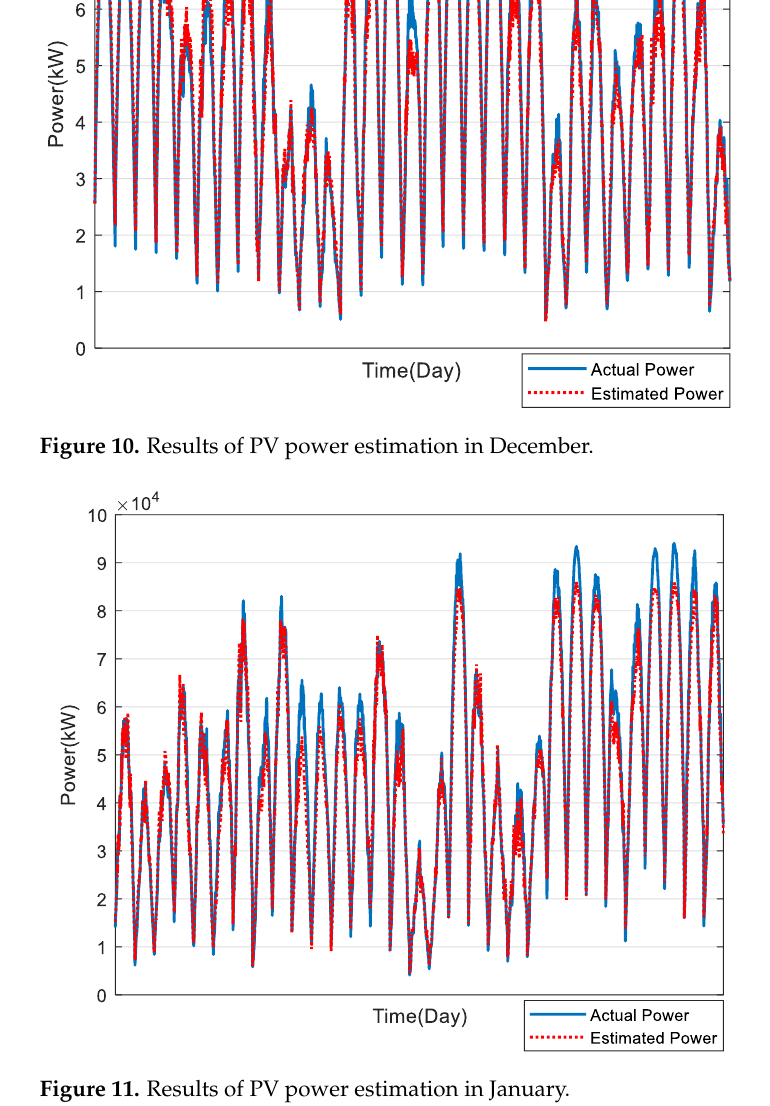
Figure 11. Results of PV power estimation in January.